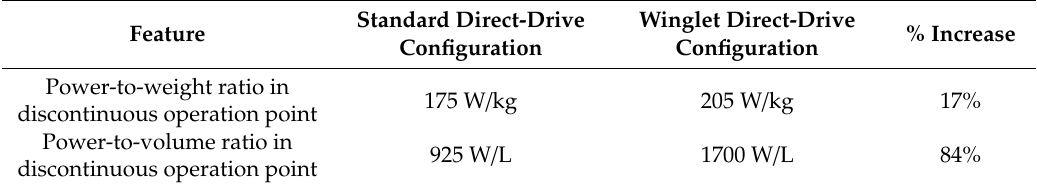
Table 2. Comparison between standard direct-drive electromechanical actuator (EMA) and winglet direct-drive